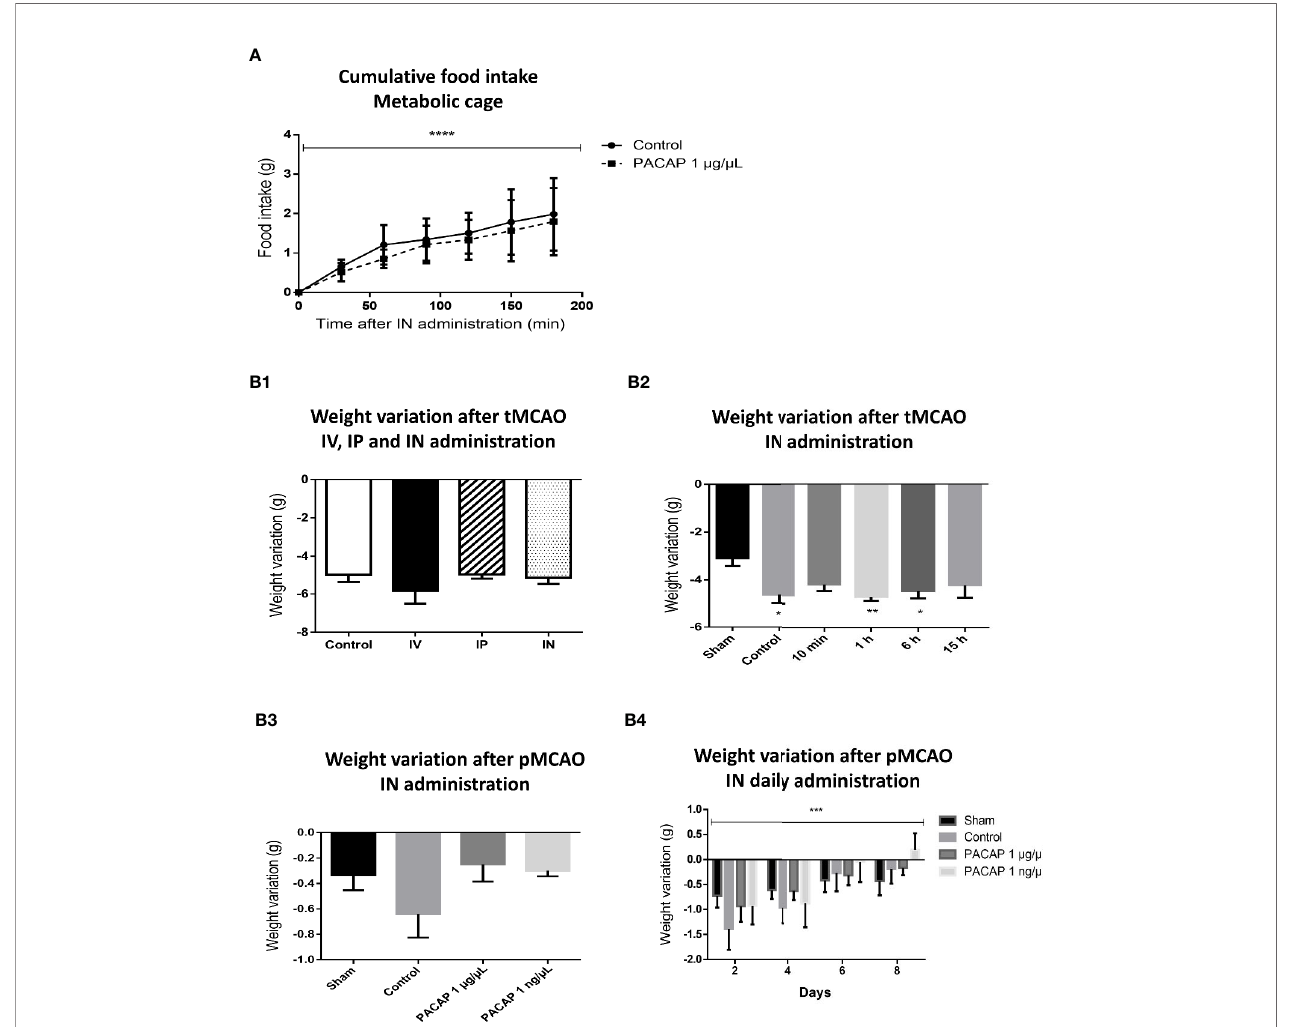
FIGURE 4 | Effects of stroke and/or PACAP treatment on cumulative food intake and body weight variation. (A) Cumulative food intake after PACAP IN delivery over 3 h of time in non-operated mice. (B) Variation of body weight after PACAP administration following different stroke protocols, i.e., PACAP administration routes protocol (B1.), PACAP therapeutic window protocol (B2.), PACAP dose response ef fi ciency protocol (B3.) and PACAP delayed IN daily administration ef fi ciency protocol (B4.). Errors are reported as Mean ± S.E.M. (*P < 0.05; **P < 0.01; ***P < 0.001). Two-way ANOVA was performed for fi gure A and B4 showing signi fi cant means only for time factor (minutes and days), while the effects of treatment and the interaction are not signi fi